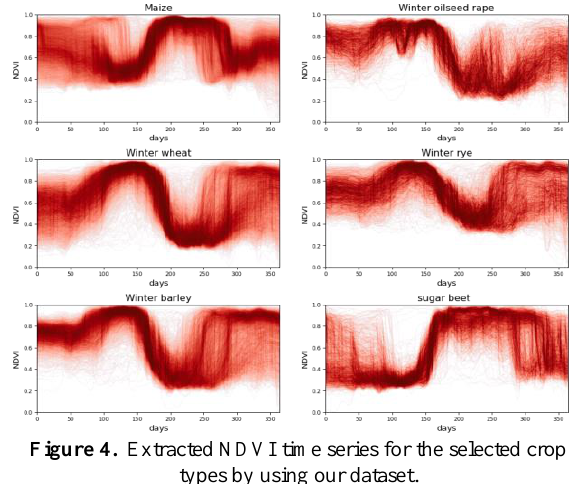
Figure 4. Extracted NDVI time series for the selected crop types by using our dataset.